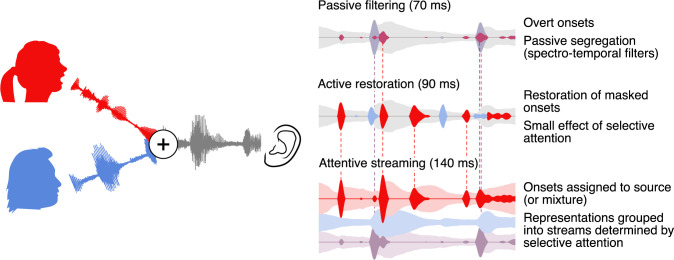
Model of onset-based stream segregation.A model of cortical processing stages compatible with the results reported here. Left: The auditory scene, with additive mixture of the waveforms from the attended and the ignored speakers (red and blue, respectively). Right: Illustration of cortical representations at different processing stages. Passive filtering: At an early stage, onsets are extracted from the acoustic mixture and representations are partially segregated, possibly based on frequency. This stage corresponds to the early positive peak in onset TRFs. Active Restoration: A subsequent stage also includes representations of onsets in the underlying speech sources that are masked in the mixture, corresponding to the first peak in TRFs to masked onsets. At this stage, a small effect of attention suggests a preliminary selection of onsets with a larger likelihood of belonging to the attended speaker. Streaming: Finally, at a third stage, the response to onsets from the ignored speaker is suppressed, suggesting that now the 2 sources are clearly segregated (see also [8]). This stage corresponds to the second, negative peak, which is present in TRFs to mixture and attended onsets but not to ignored onsets. TRF, temporal response function.